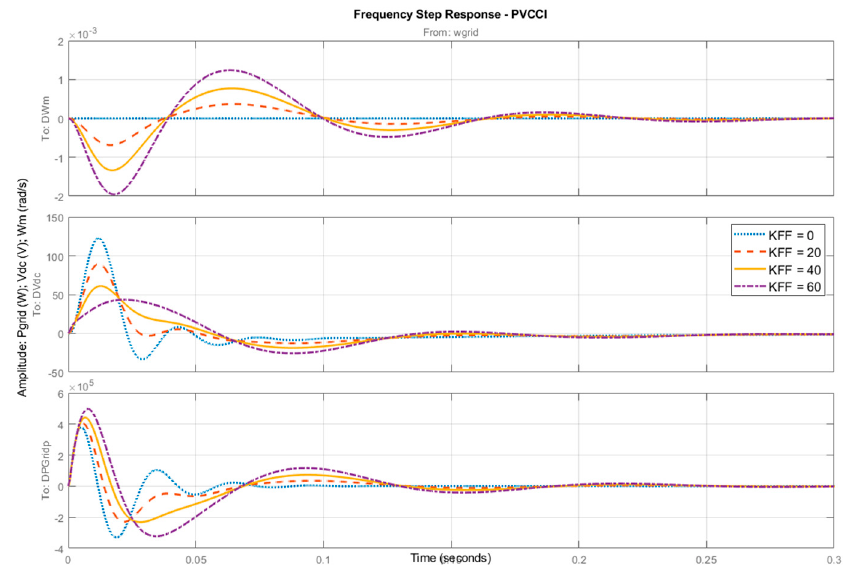
Figure 24. PVCCI frequency step response with feedforward to the generator.